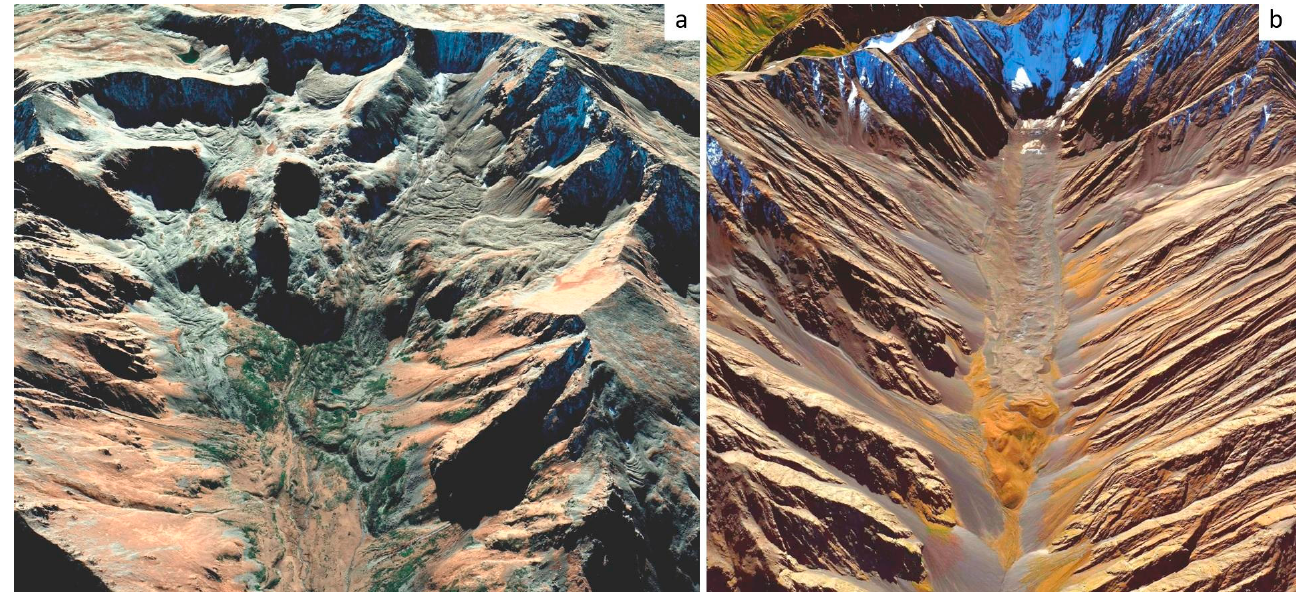
Figure 9. Examples of complex rock glacier terrain with hard-defined boundaries. ( a )—active rock glaciers (upper part) versus relict rock glaciers (lower part) (43°30 ′ 6.58 ″ N 41°6 ′ 46.16 ″ E). ( b )—debris-covered glacier (upper part) versus active rock glacier (lower part) (42°42 ′ 3.67 ″ N 44°50 ′ 44.61 ″ E). Google Earth imagery 26/10/2020 ( a ) and 22/09/2011 ( b ) is used as the background. © Google Earth 2022.